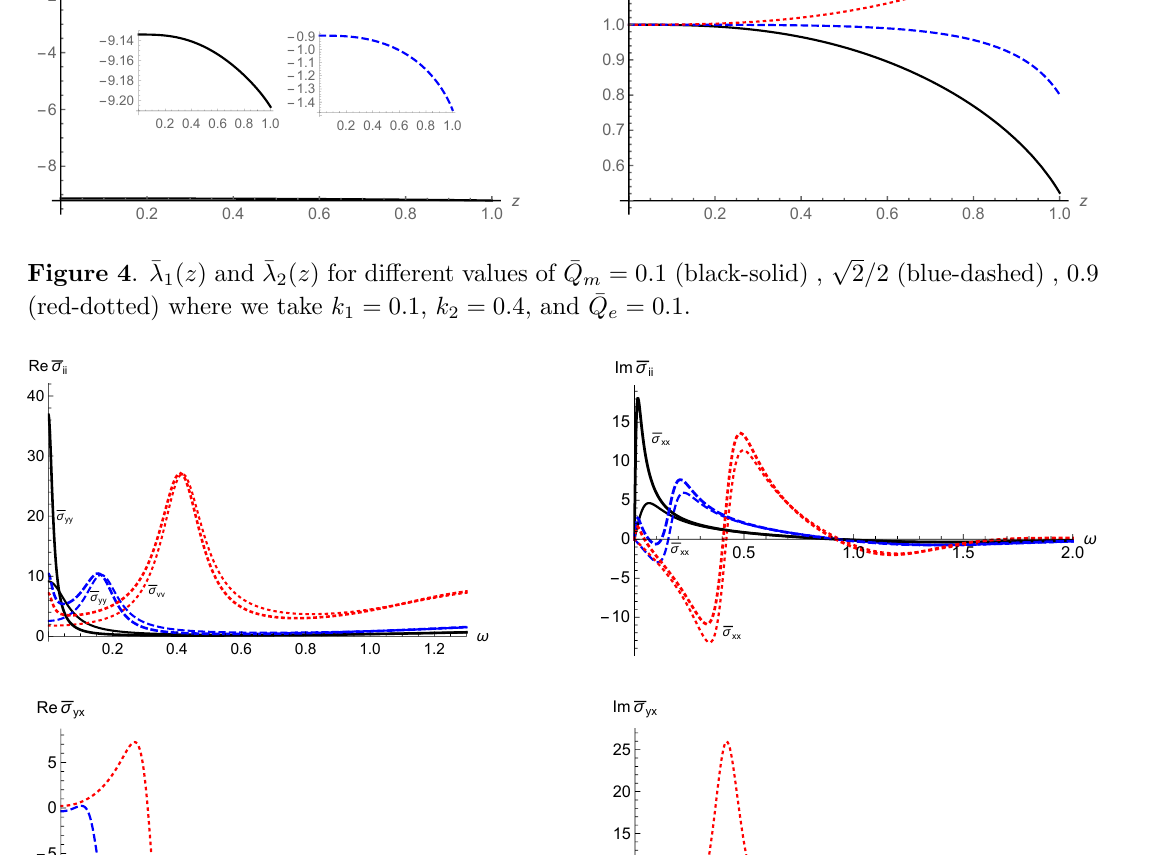
Figure 5 . The AC conductivities (cid:22) (cid:27) ii and Hall conductivities (cid:22) (cid:27) yx in terms of frequency ! , for p di(cid:11)erent values of (cid:22) Q m = 0 : 1 (black-solid) , 2 = 2 (blue-dashed) , 0 : 9 (red-dotted) where we take k 1 = 0 : 1, k 2 = 0 : 4, and (cid:22) Q e = 0 : 1. In the (cid:12)rst two plots, we only indicate either (cid:22) (cid:27) xx or (cid:22) (cid:27) yy , the accompanying lines are just theirs partners for (cid:22) (cid:27) yy or (cid:22) (cid:27) xx